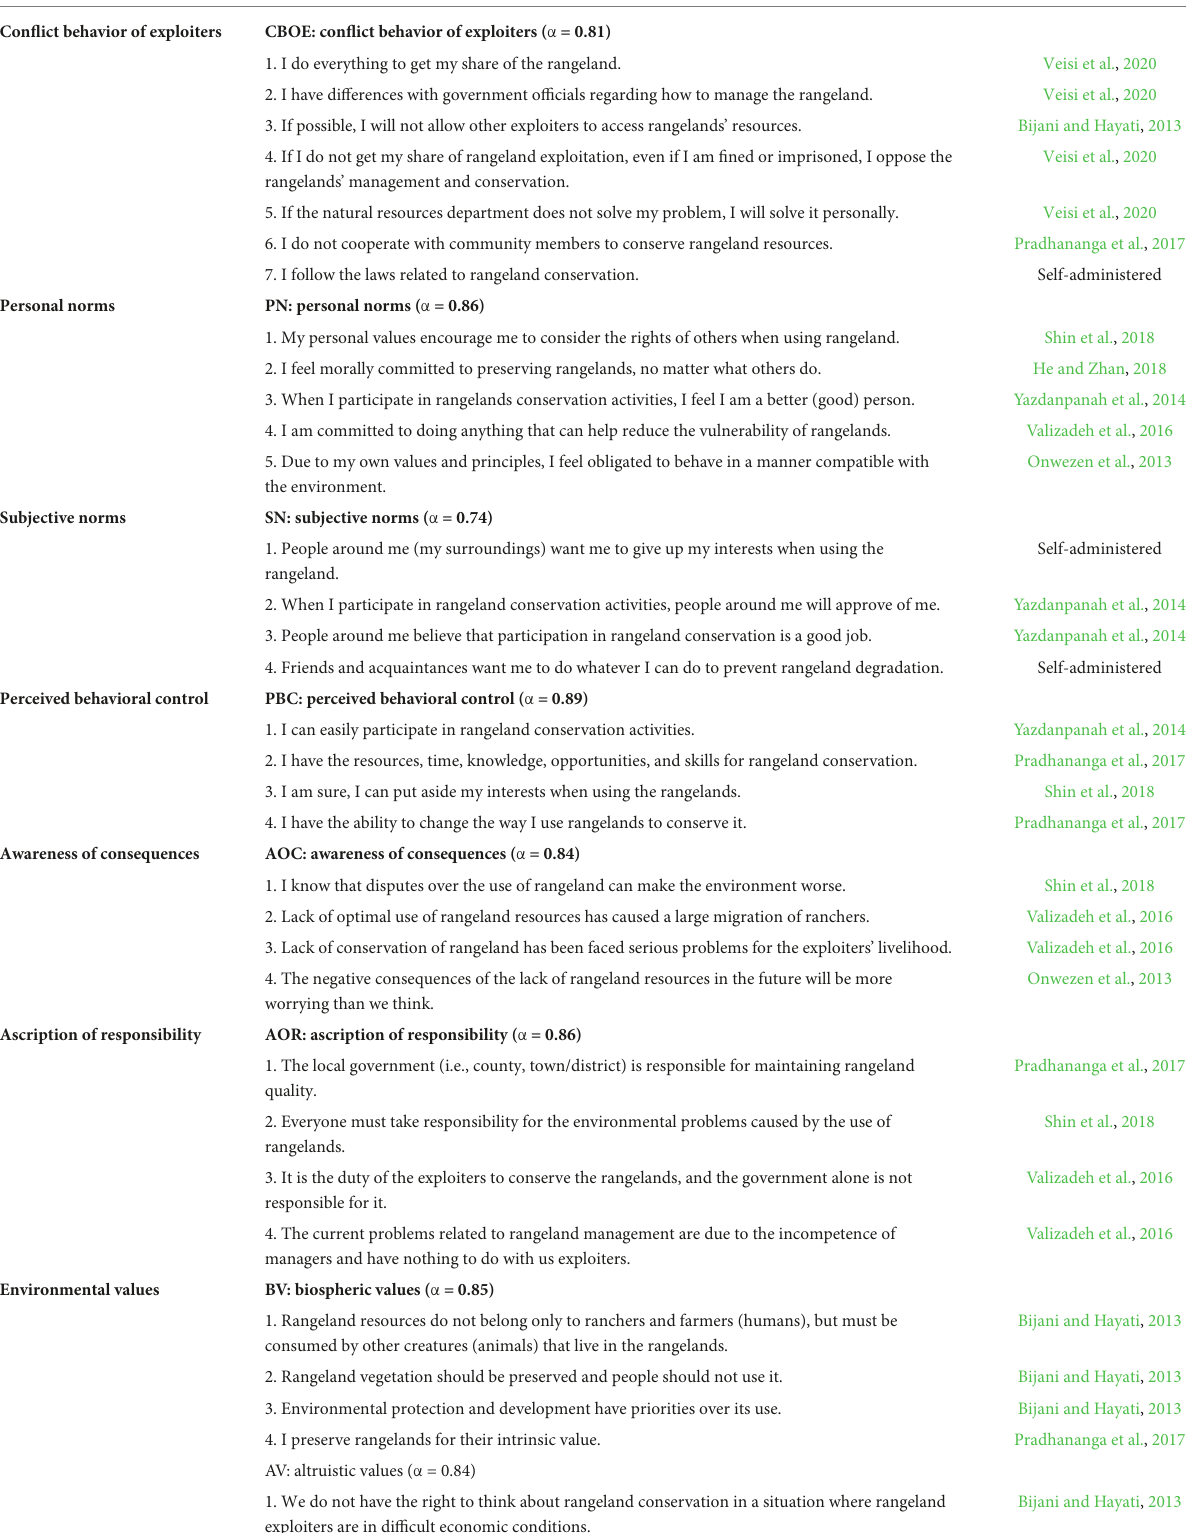
TABLE 2 Survey items and Cronbach’s alpha coefficients. Variables Items Source Conflict behavior of exploiters CBOE: conflict behavior of exploiters ( α =